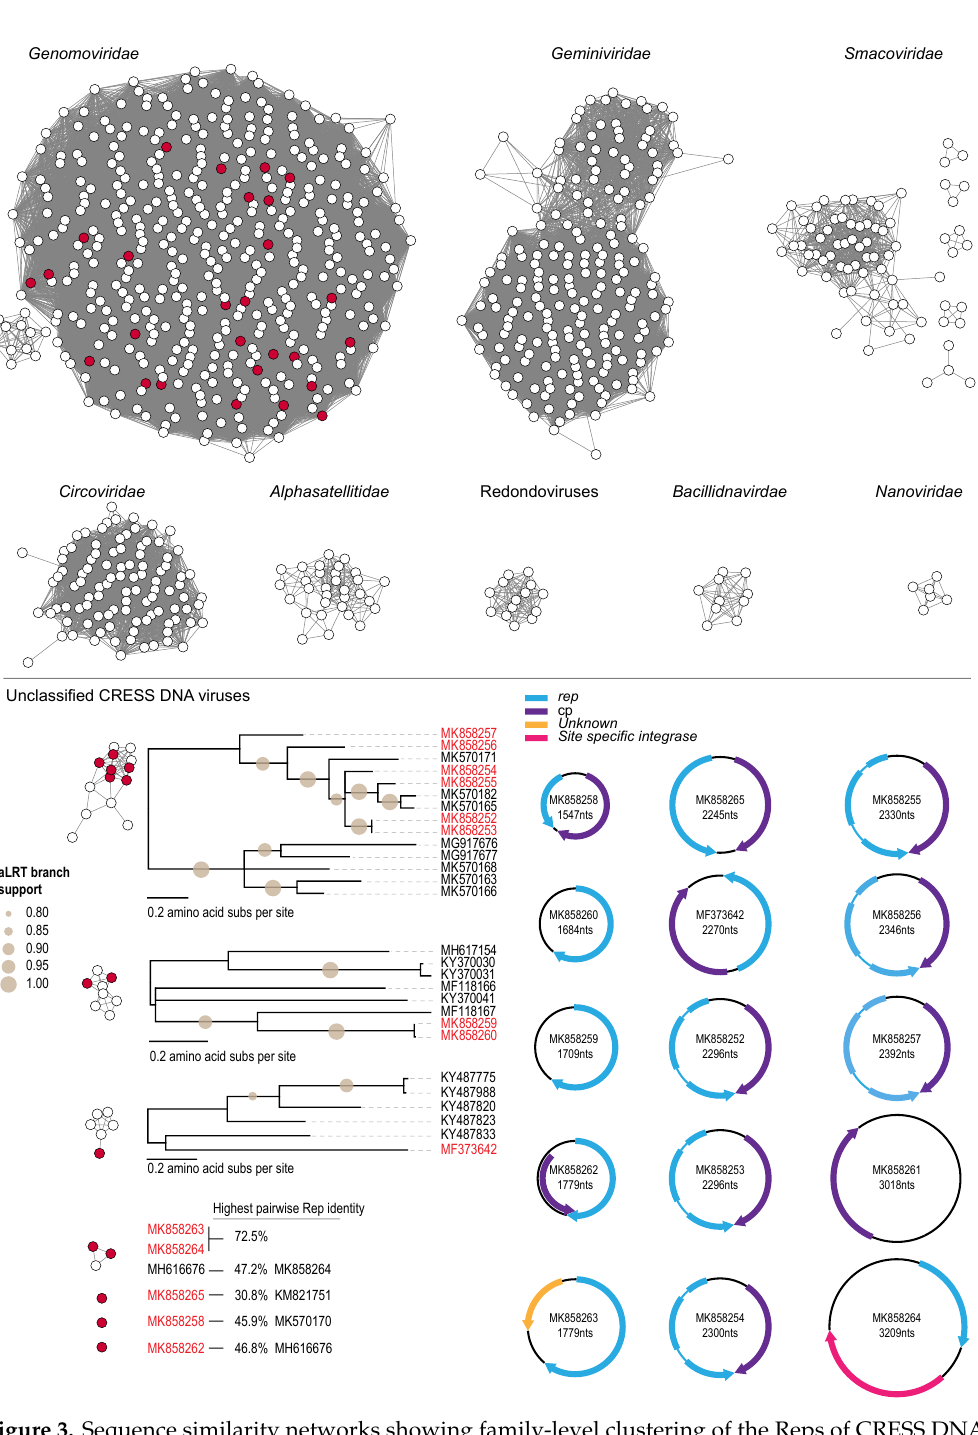
Figure 3. Sequence similarity networks showing family-level clustering of the Reps of CRESS DNA viruses and Rep-encoding circular molecules. For each cluster that has a Rep from this study (colored in red), a phylogenetic tree (midpoint rooted) has been inferred for all sequences belonging to the cluster. Six of the unclassified CRESS DNA viruses (MK858252-MK858257) have a similar genome organization, i.e., their CP is encoded on the virion sense and their Rep (that has two predicted introns) on the complementary sense. These six genomes share > 62% genome-wide nucleotide identity and all have a ‘TAAGATTAC’ nonanucleotide motif. Their Reps share > 56% amino acid identity, whereas their CPs share > 54% amino acid identity. These Rep amino acid sequences cluster in the SSN and phylogenetically with Reps of viruses from a termite mound (sampled in Kenya) [70] and